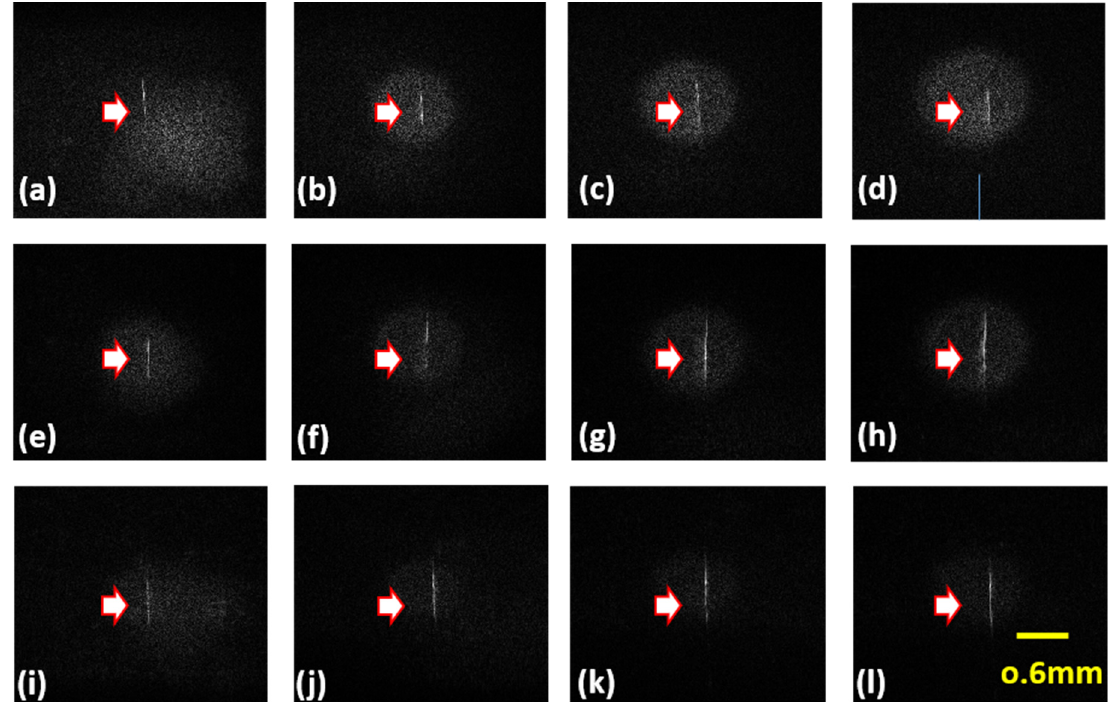
Figure 6. The target images taken from the DHD system with normal direction of the sample tilting 7° from the incident angle. The paint on the back surfaces of the glass was ( a – d ) white, ( e – h ) gray, and ( i – l ) black. ( a , e , i ) in the first column show the reconstructed pictures with the interference fringe suffering 3 mm defocus; ( b , f , j ) in the second column show the reconstructed pictures with the interference fringe suffering 6 mm defocus; ( c , g , k ) in the third column show the reconstructed pictures with the interference fringe suffering 9 mm defocus; ( d , h , l ) in the third column show the reconstructed pictures with the interference fringe suffering 12 mm defocus.